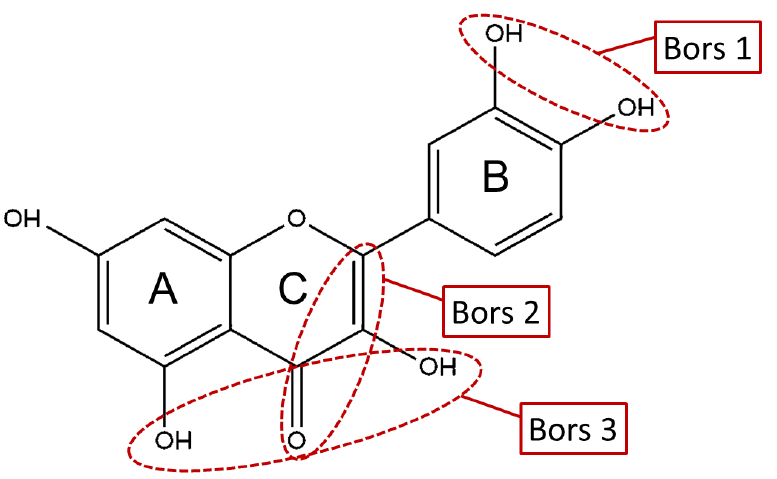
Figure 1. Structure activity relationship based on Bors criteria. Bors 1—catechol group on the B-ring; Bors 2—2,3 double bond and 4-oxo group on the C-ring; Bors 3—OH groups at position 3 and 5 OH group on the A- and C-rings and 4-oxo group on the